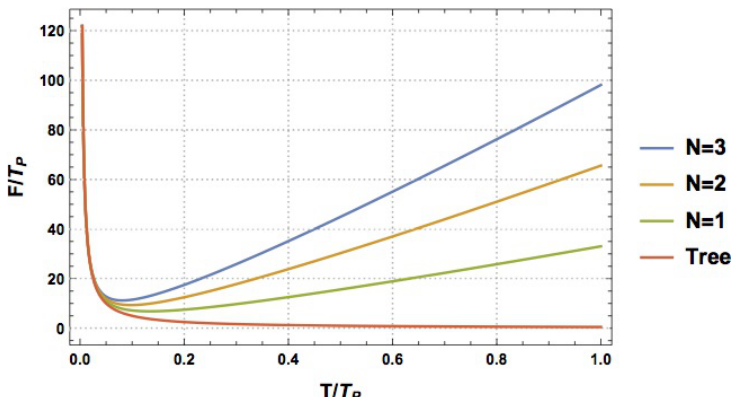
Figure 4 . The free energy as a function of the temperature of Schwarzschild black hole at tree level and including the one-loop contribution. Without loss of generality, only the contribution of the graviton to (cid:4) is considered. Here, N is an overall multiplicative factor to mimic the e(cid:11)ect of increasing N s ( N f ) and T QG =T P = 0 :